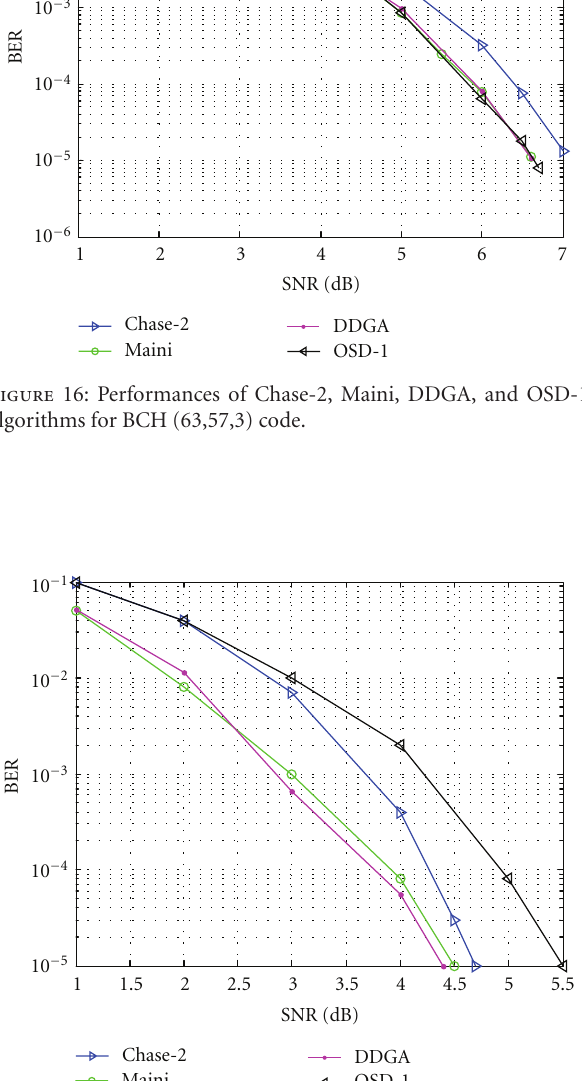
Figure 15: Performances of Chase-2, OSD-1, Maini, and DDGA algorithms for BCH (63,51,5) code.